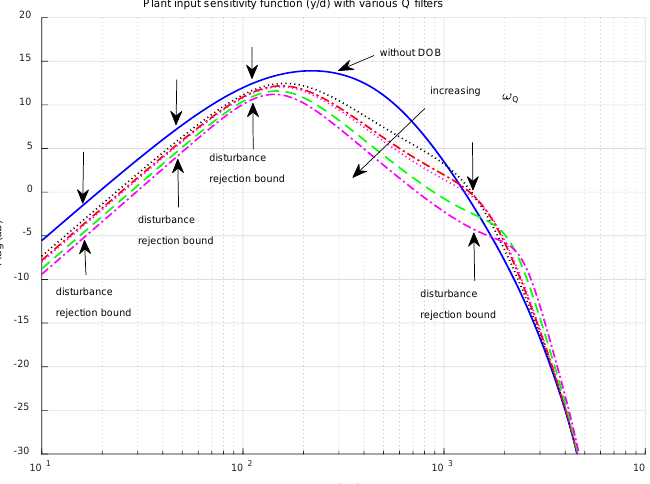
Figure 4. Feature of conventional DOB.